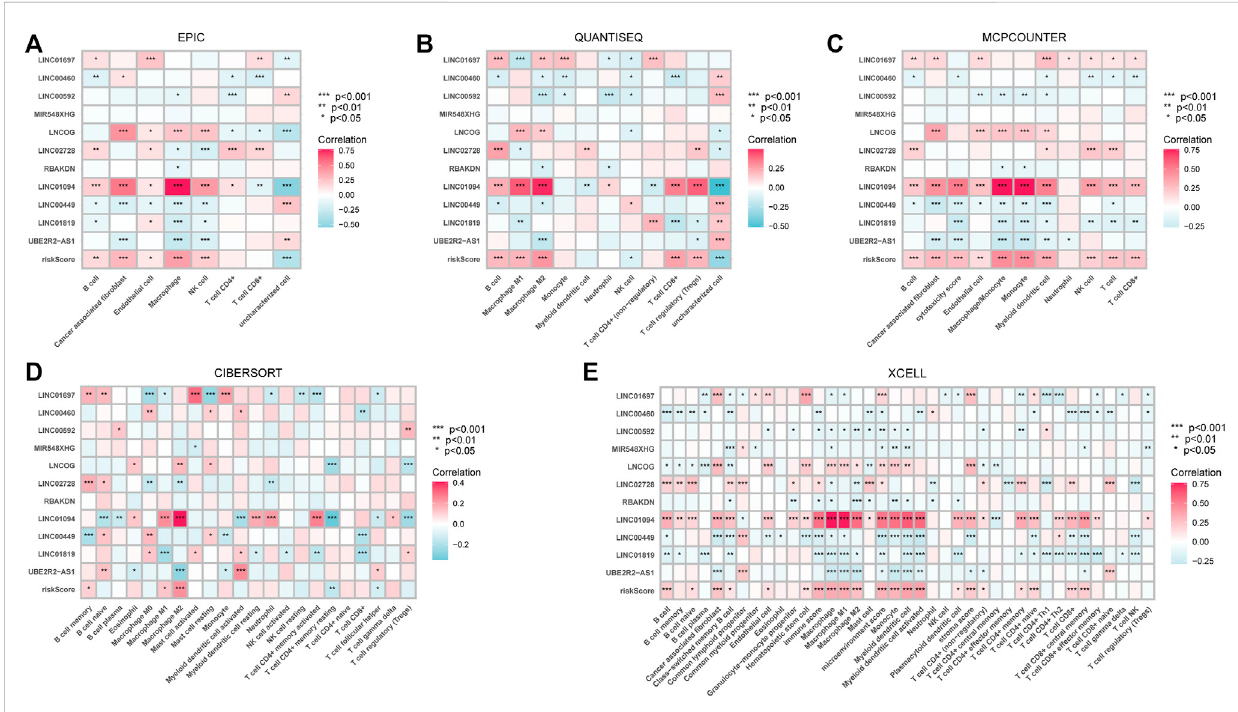
FIGURE 10 The relationship between immune cell in fi ltration and risk score in the tumor immune microenvironment of STAD patients calculated by different algorithms. (A) EPIC (B) . QUANTISEQ (C) . MCPCOUNTER (D) . CIBERSORT (E) . XCELL. * p < 0.05; ** p < 0.01; *** p <